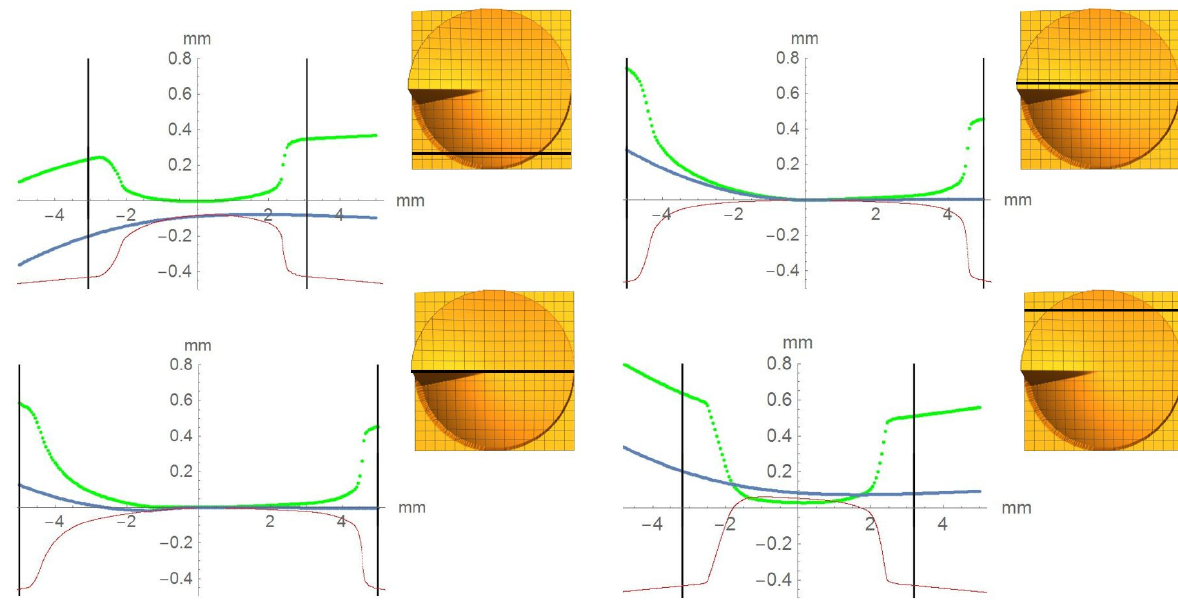
Figure 7. Measured profile (red), nominal profile (blue), and difference profile (green) inside the nominal aperture (solid black and perpendicular lines). Insets: position of the respective profile on the surface. The figure shows nominal profiles (blue), measured profiles (red), and difference profiles (green) inside the limits of the nominal aperture (perpendicular solid black